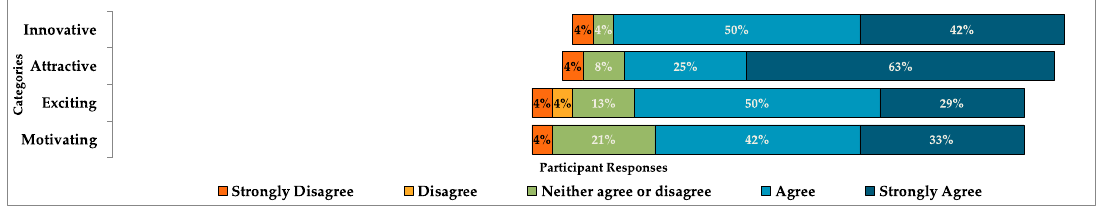
Figure 5. Skill prototype User Perception